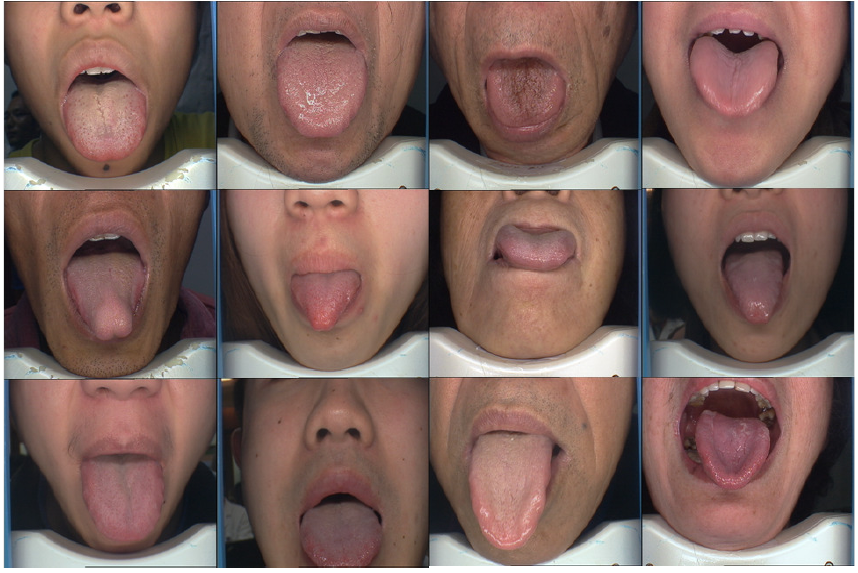
Figure 8. Samples of tongue image dataset. Table 2. Overview information of the tongue image dataset.